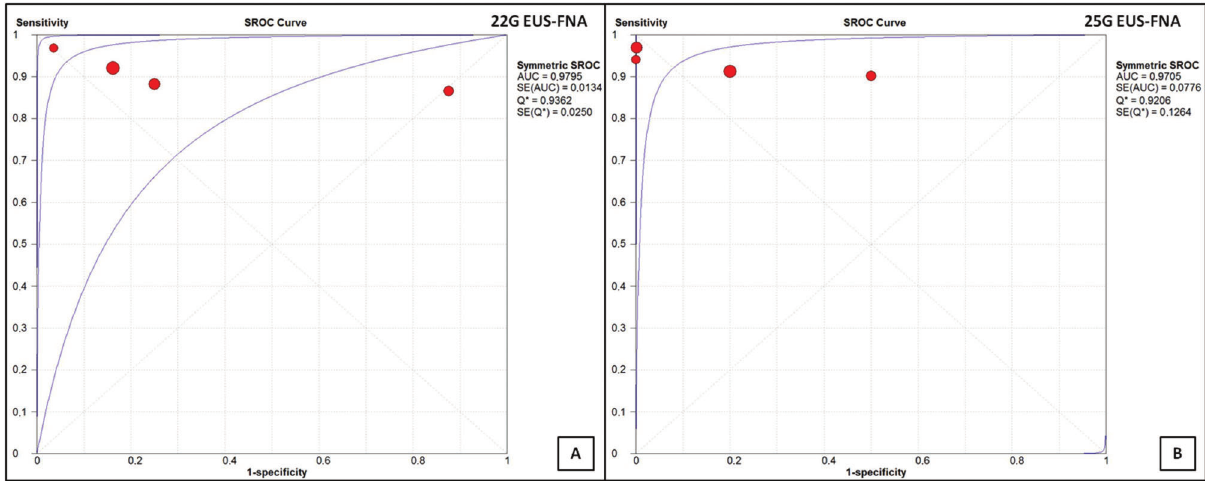
Figure 6 - (A) sROC curve for EUS-FNA with the 22G needle. Area under the curve of 97.95%. (B) sROC curve for EUS-FNA with the 25G needle. Area under the curve of